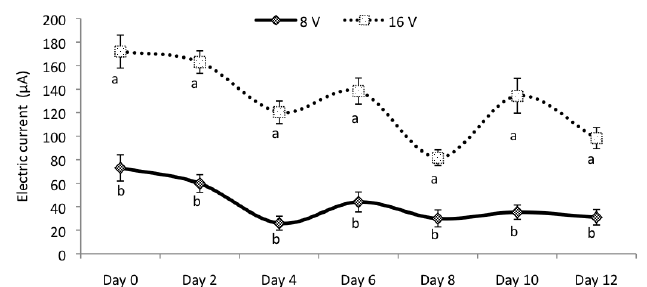
Fig. 2: Changes in current flow on African nightshade plants during pro - duction as influenced by DC intensity. Means (± standard deviation) followed by the same letter are not significantly different according to t-test ( p <